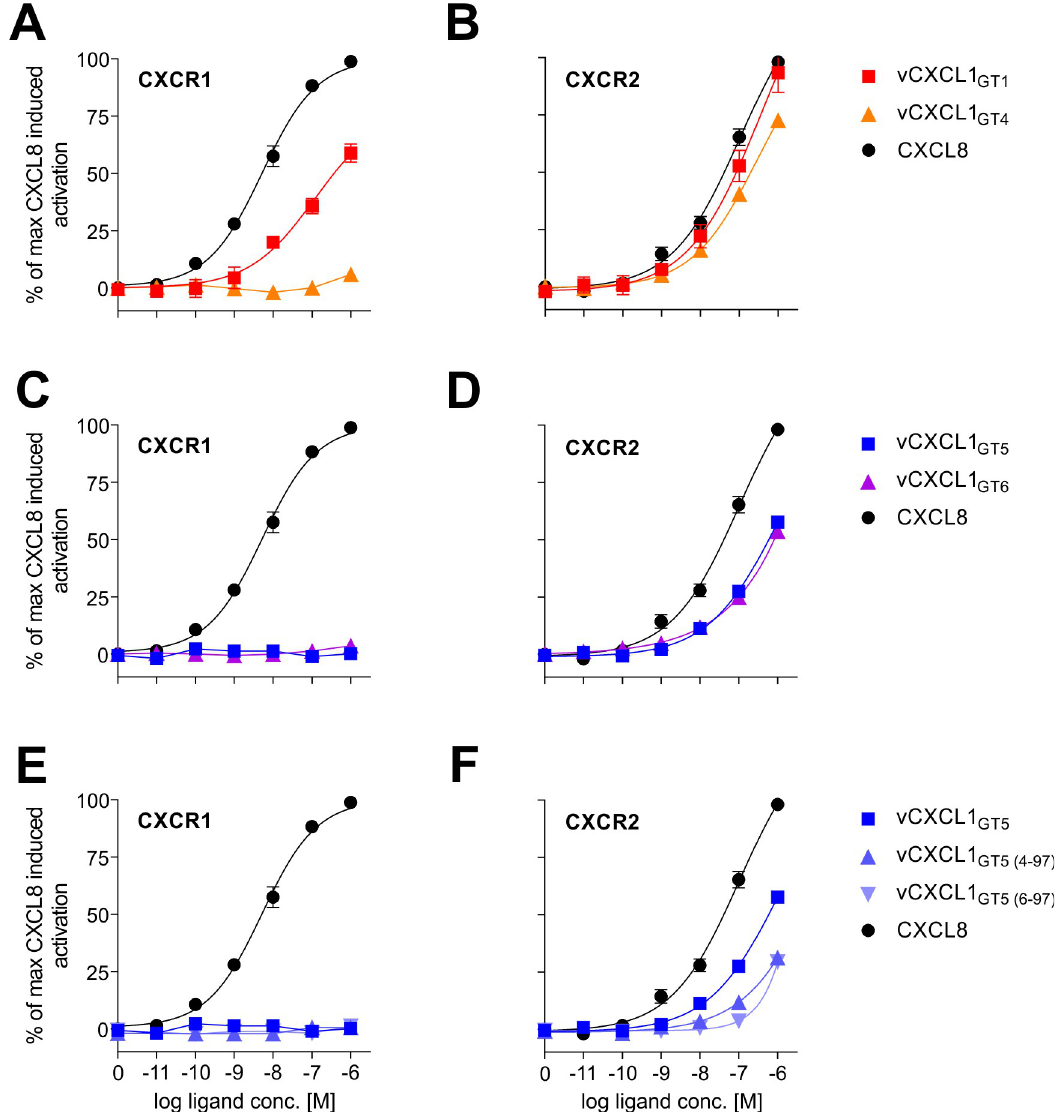
Fig 5. Dose/response activity of vCXCL1 GT1 , vCXCL1 GT4 , vCXCL1 GT6 , and vCXCL1 GT5 variants on G protein signaling of CXCR1 and CXCR2. G protein signaling of CXCR1 and CXCR2 by vCXCL1 GT1 and vCXCL1 GT4 (A+B) , wild-type vCXCL1 GT5 and vCXCL1 GT6 (C+D) , and vCXCL1 GT5 (4–97) , and vCXCL1 GT5 (6–97) (E+F) in an IP accumulation assay. Error bars presented as SEM. For CXCR1, the number of repeated observations for each sum curve were: CXCL8 n = 10; vCXCL1 GT1 n = 8; vCXCL1 GT4 n = 3; wild-type vCXCL1 GT5 n = 10; vCXCL1 GT6 n = 3; vCXCL1 GT5 (4–97) n = 4; vCXCL1 GT5 (6–97) n = 4. For CXCR2, the number of repeated observations for each sum curve were: CXCL8 n = 10; vCXCL1 GT1 n = 8; vCXCL1 GT4 n = 3; wild-type vCXCL1 GT5 n = 10; vCXCL1 GT6 n = 3; vCXCL1 GT5 (4–97) n = 3; vCXCL1 GT5 (6–97) n =